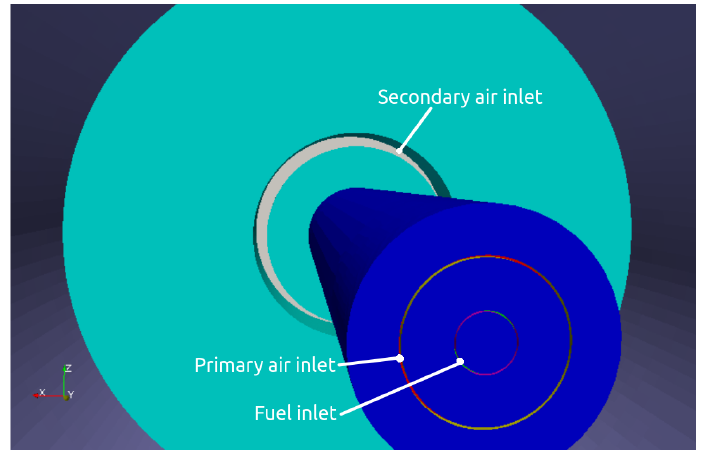
Figure 7. Modified kiln geometry C where all three inlets are annular shaped.